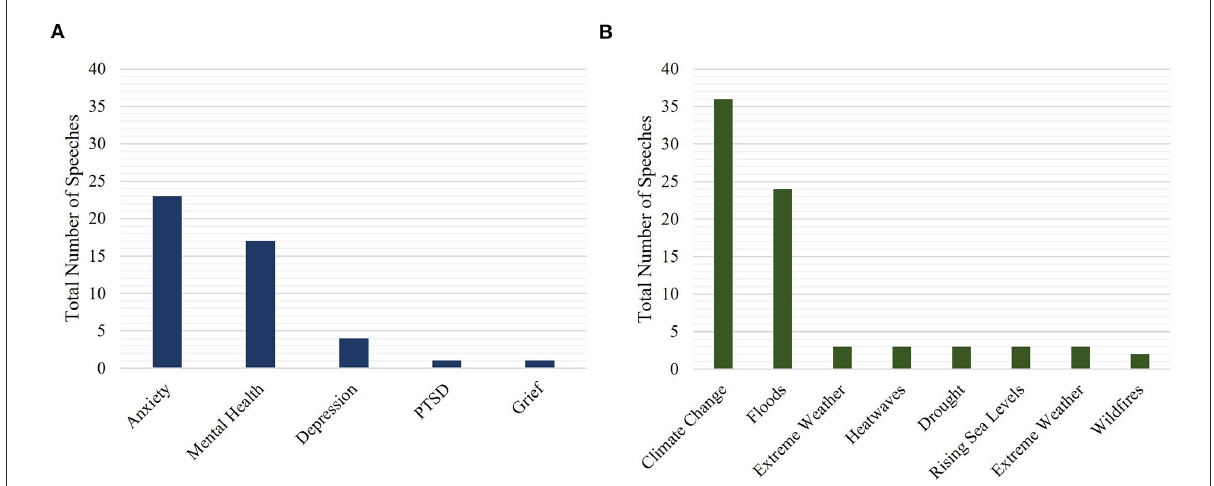
FIGURE4 Frequency of specific terms related to (A) mental health and (B) climate change. The analysis includes only speeches where direct links between mental health and climate change were mentioned, for the time period between 01/01/2001 and 31/12/2020 ( N = 41). Some speeches mentioned more than one key